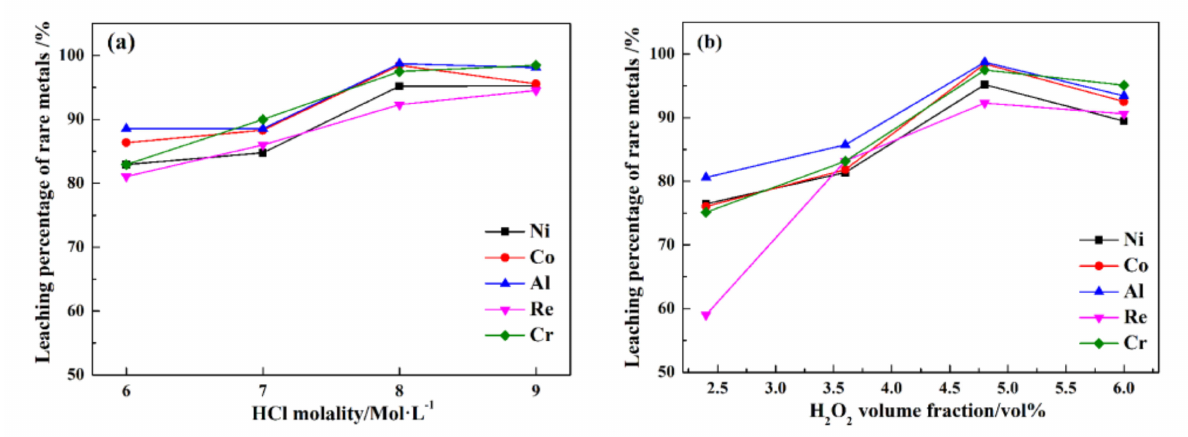
Figure 7. The leaching percentages of rare metals in different HCl ( a ) and H 2 O 2 dosages ( b ). In Figure 7a, HCl can enhance the ultrasonic leaching process of rare metals recovery from superalloy scraps. When the HCl molality increases from 6 to 8 mol/L, the leaching percentages of Re, Ni, Co, Al, and Cr increase from 81.1%, 82.9%, 86.4%, 88.5%, and 82.9% to 92.3%, 95.2%, 98.5%, 98.7%, and 97.5%, respectively. As the HCl molality increases to 9 Mol/L, the leaching percentages of Re, Ni, Co, Al, and Cr are 94.5%, 95.2%, 95.4%, 98.1%, and 98.5%, respectively, and the improvement effect is not obvious. In Figure 7b, when the H 2 O 2 dose increases from 2.4 to 4.8 vol%, the leaching percentages of Re, Ni, Co, Al, and Cr increase from 58.9%, 76.5%, 76.1%, 80.6%, 75.1%, and 25.7% to 92.3%, 95.2%, 98.5%, 98.7%, and 97.5%, respectively. Increasing the H 2 O 2 dose can effectively improve the leaching percentages of Ni, Co, Al, and Cr, especially the leaching rate of Re. As the H 2 O 2 dose increases to 6.0 vol%, the leaching percentages of Re, Ni, Co, Al, and Cr are 90.6%, 89.4%, 92.5%, 93.4%, and 95.1%, respectively. It is observed that the